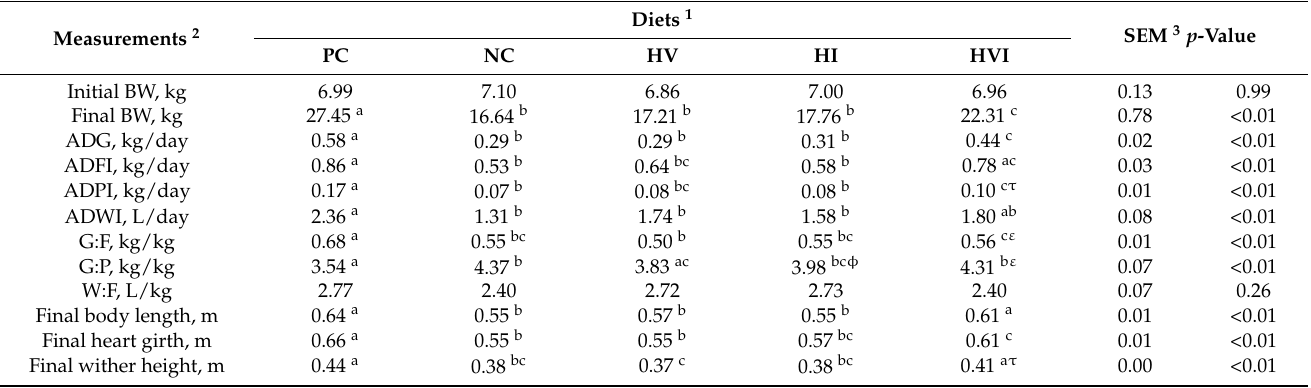
Table 3. Growth performance of nursery pigs fed with very low-protein diets containing isoleucine, valine or mix of both above NRC